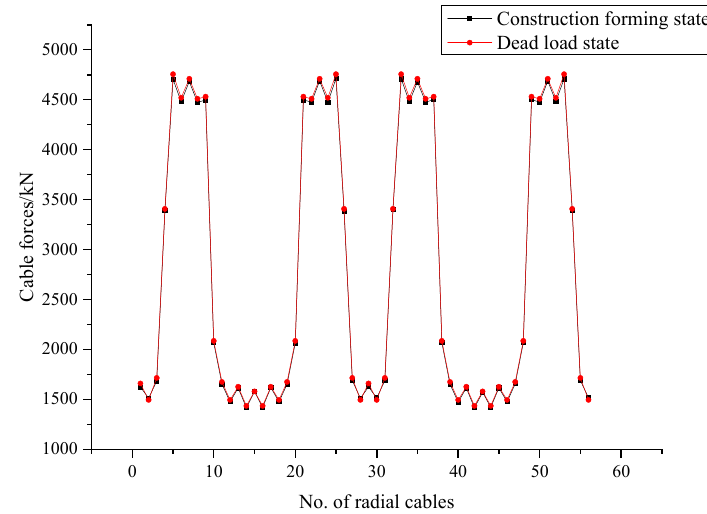
Figure 57. Comparison curve of vertical reaction force of structure in two states (kN).